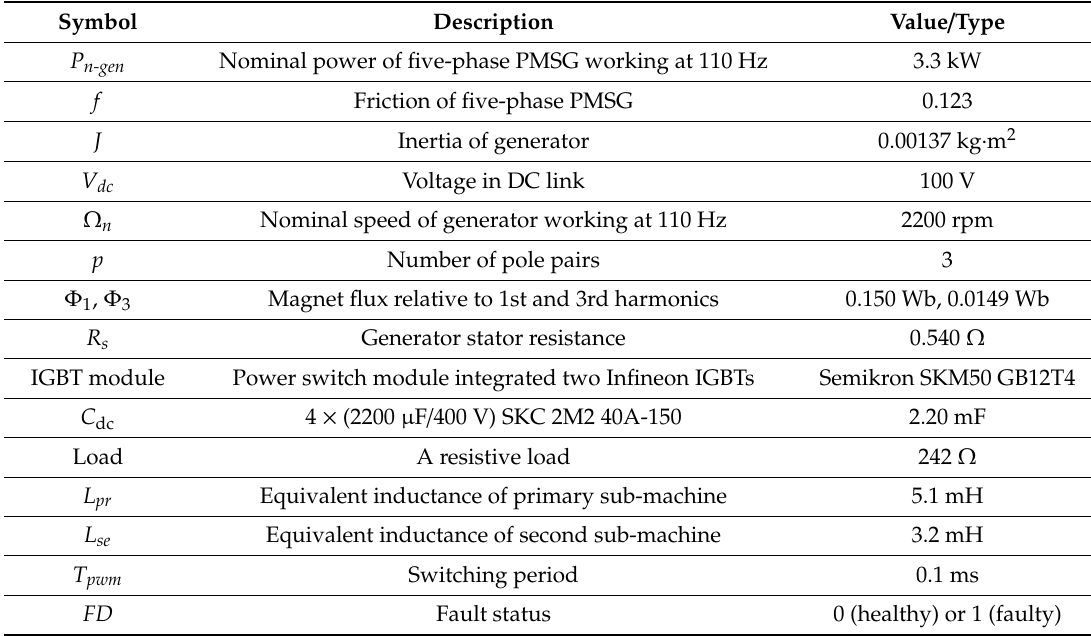
Table A1. Parameters of the full-physical experiment platform.